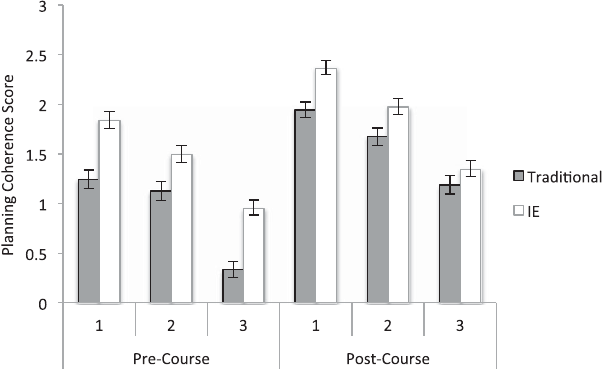
FIG. 3. Pre- and postcourse planning coherence score as a function of problem number and class format (total possible score ¼ 3 ). Error bars represent the standard error.